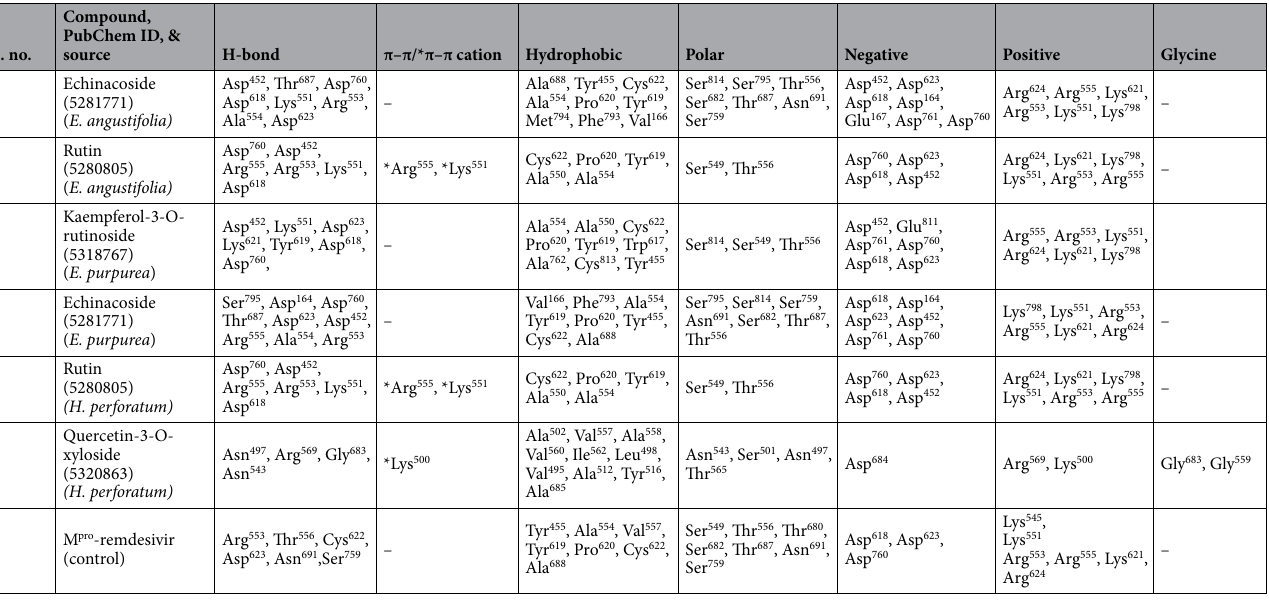
Table 2. Molecular interaction analysis of SARS-CoV-2 RDRP with selected phytochemicals from selected